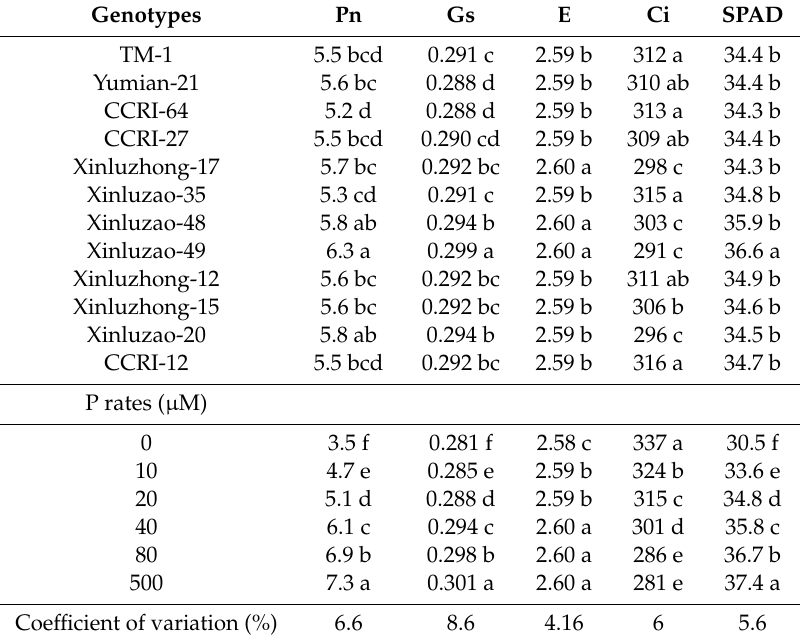
Table 4. Photosynthetic rate (Pn, µ mol CO 2 m − 2 s − 1 ), stomatal conductance (gs, mmol H 2 O m − 2 s − 1